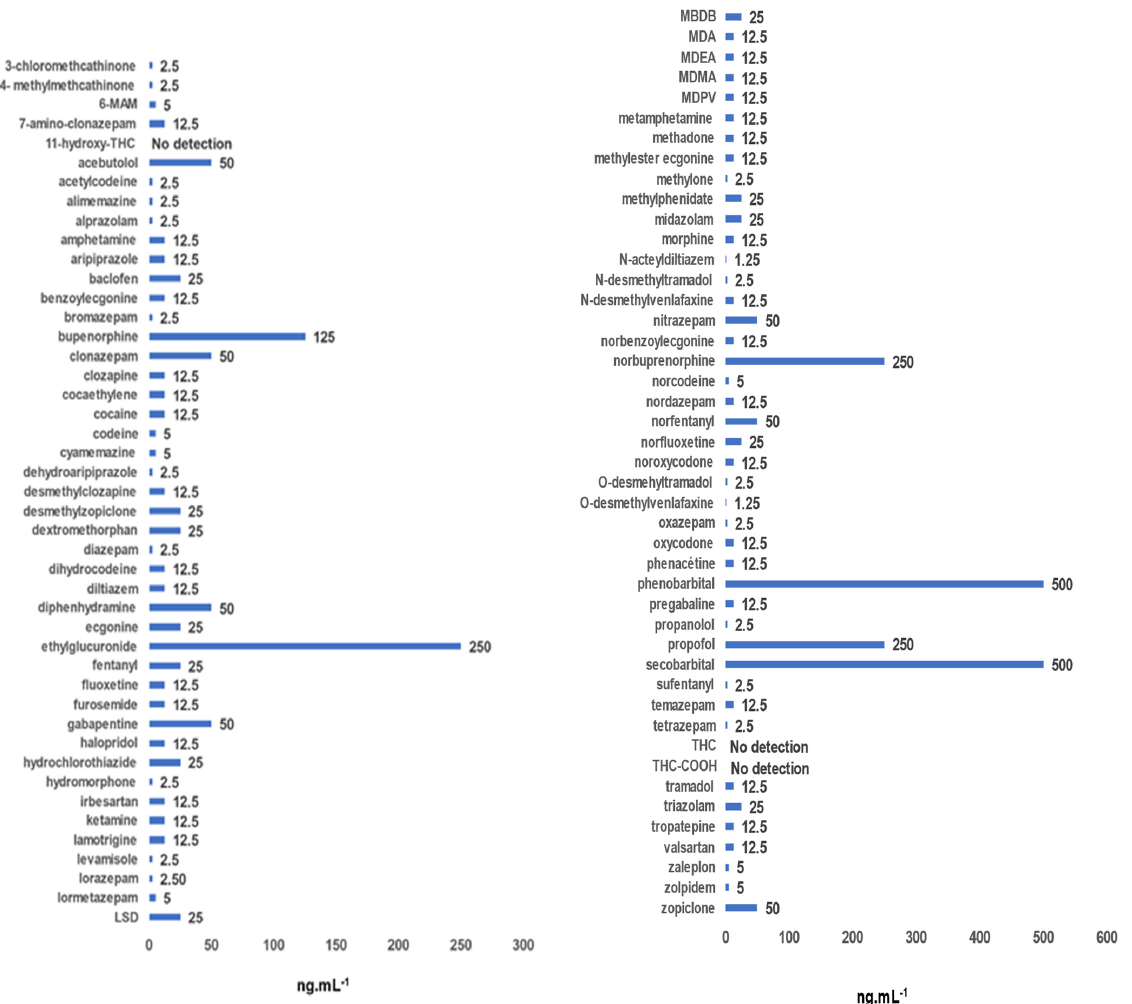
Figure 2. Limits of identi fi cation of 90 compounds spiked in working solutions at di ff erent concen- trations from 250 to 1.25 ng·mL − 1 . The values of the identi fi cation limits are speci fi ed for each